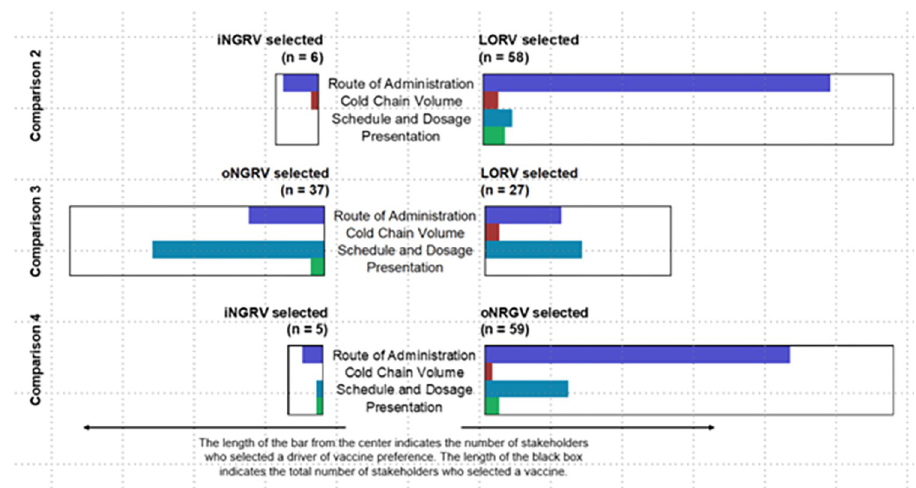
Fig 2. Vaccine preferences by main attribute